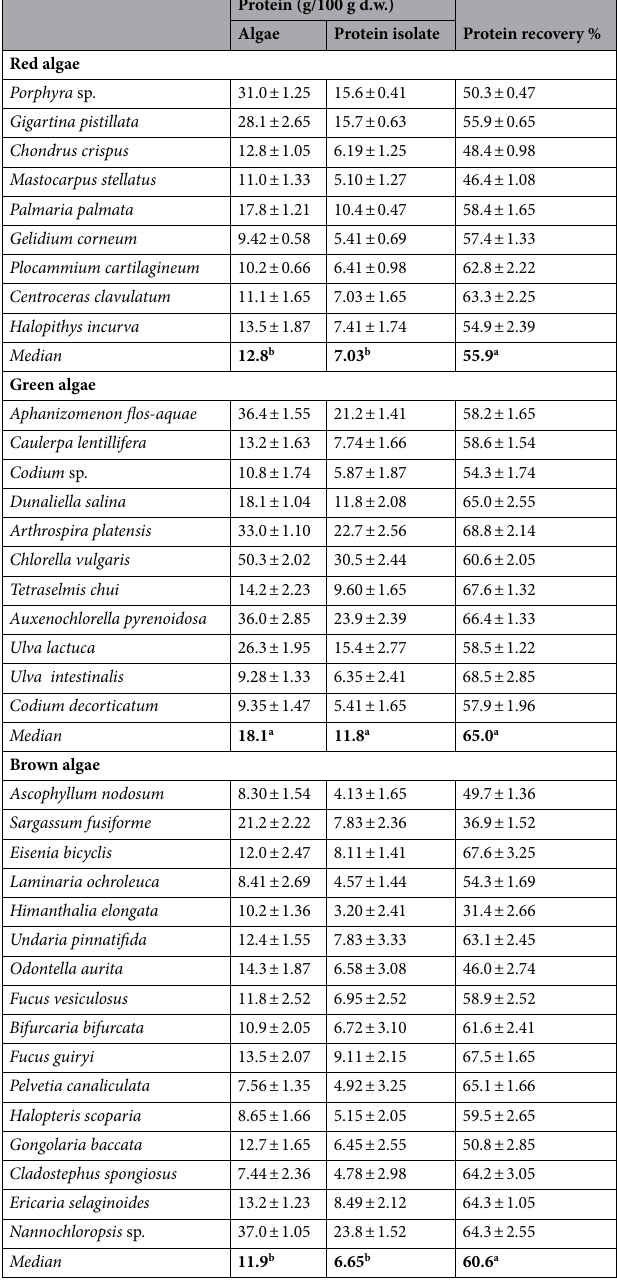
Table 1. Protein content (in the algae samples and in their protein isolates) and protein recovery (mean of n = 3 independent determinations ± SD). Significant values are in bold. Different small letters in the same column indicate significant differences between medians of the algae groups ( p <